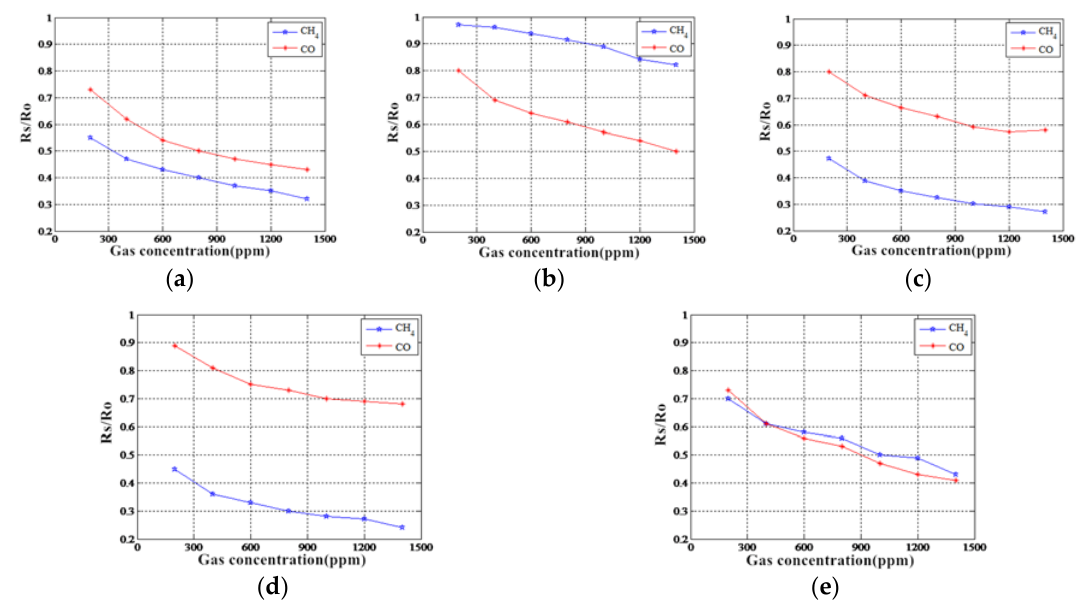
Figure 4. Sensitivity characteristic curves of MOS gas sensor array response to different target gases.